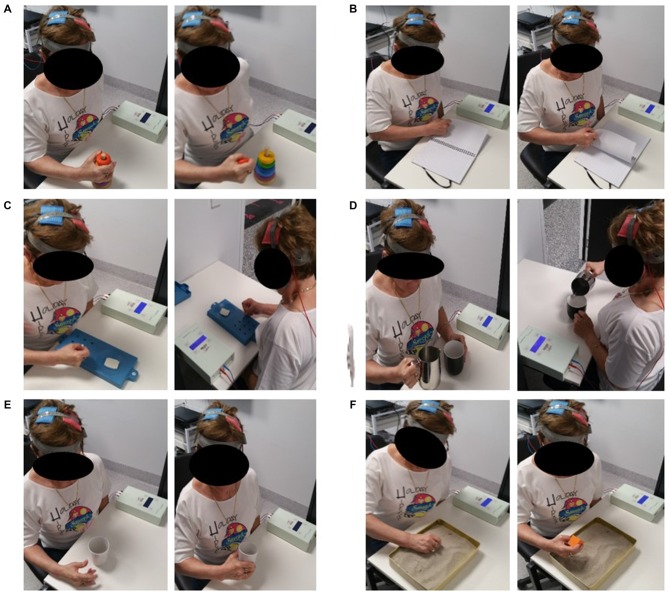
One participant undertaking a selection of the above upper limb (UL) rehabilitation exercises during the application of bihemispheric transcranial direct-current stimulation (bihemispheric-tDCS). Exercises shown include: grasping task using stacking blocks (A); turning pages of a scrapbook (B); nine-hole pegboard (C); grasping saucepan and pouring water into a cup (D); opening hand using finger and wrist extension to grasp and pick up cup (E); feeling for blocks in sand and picking them up (F). The picture on the left depicts the beginning of the task whilst the right shows the end range of the task.